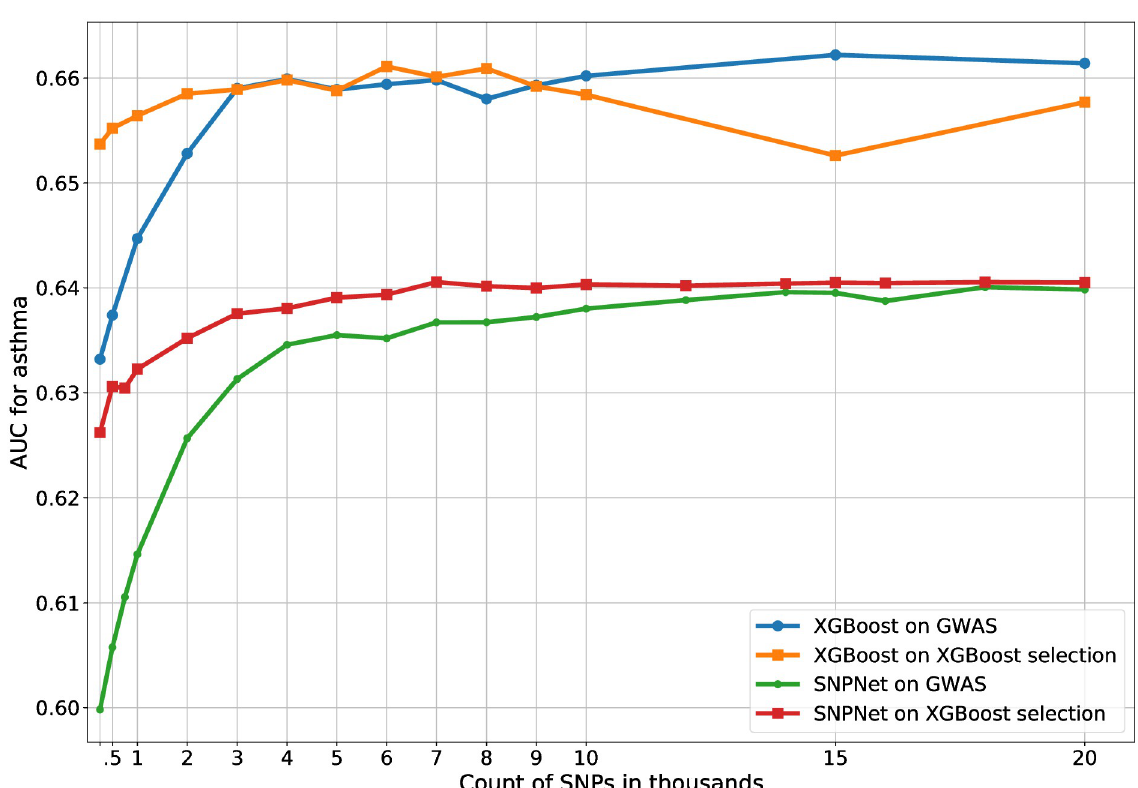
Fig 7. Dependence of the final model accuracy on the number of SNPs for four different combinations of selection and prediction methods for asthma. Both XGBoost selection and XGBoost prediction used depth-2 models. The features include 20 covariates, age, sex, and 10 principal